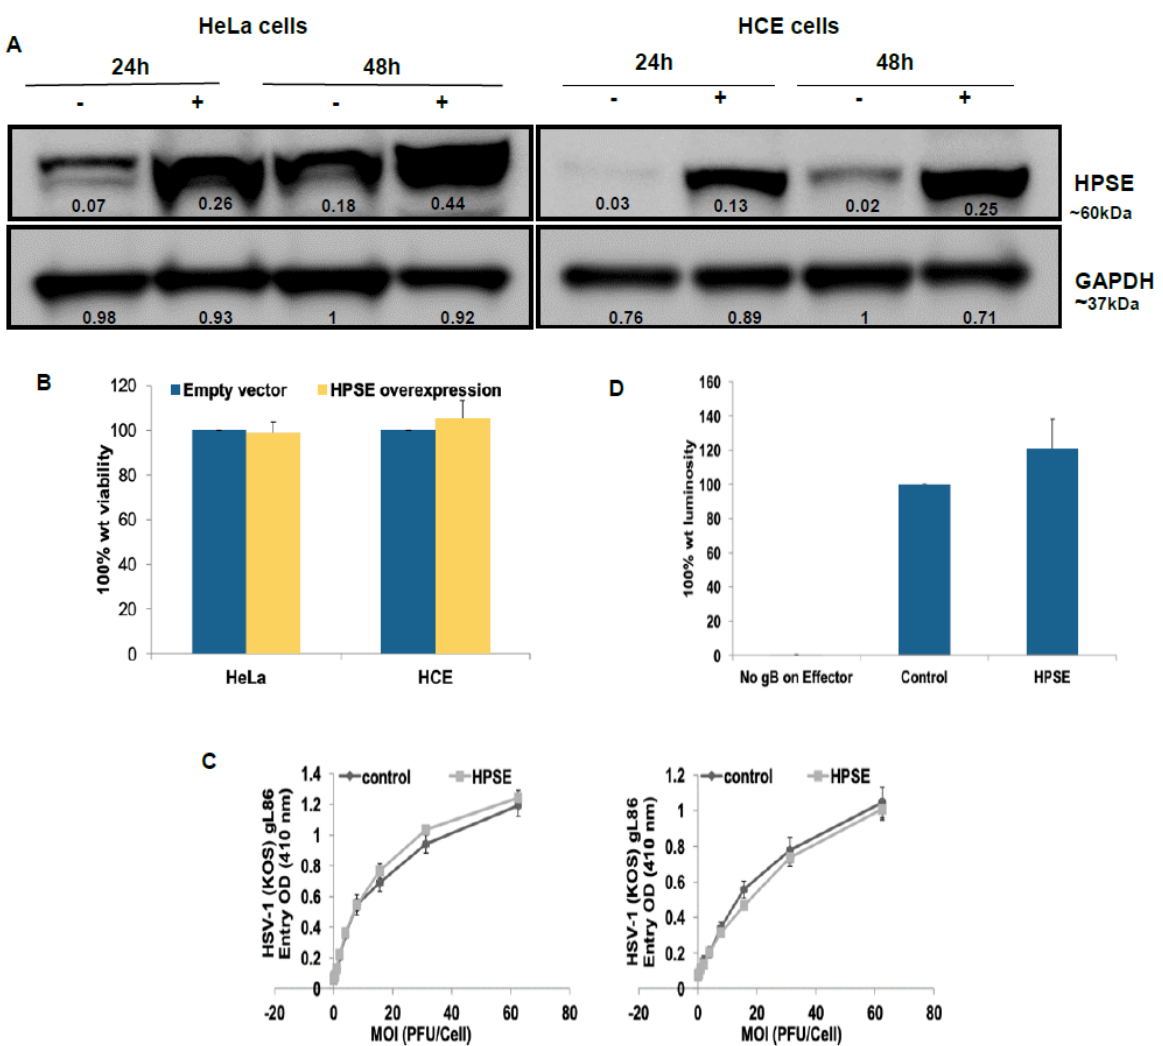
Figure 1. HPSE overexpression does not affect cell viability, cell entry, and cell–cell fusion in HeLa and HCE cells. ( A ) HeLa and HCE cells were transfected with human HPSE expression plasmid or with a control empty vector (control). Then, 24 and 48 h post transfection immunoblot of cell lysates were prepared and probed with anti-HPSE antibody. − : un-transfected cells, +: transfected cells. GAPDH protein level was measured as loading control. Representative blots of three independent experiments are shown. The densitometry quantification values are represented on the blot indicating the signal intensity with respect to the GAPDH (control). ( B ) Cells were grown in 96-well plates, transfected with HPSE expression plasmid or with a control empty vector. 24 h post transfection, triplicate wells were evaluated for cell viability using MTS assay. Results are expressed as 100% wild-type (wt) viability where they represent the percent corrected absorbance after subtracting the background absorbance, relative to empty vector transfected cells, and are mean ± 1 SD of three independent experiments. ( C ) HeLa and HCE cells were transfected with either HPSE expression plasmid (HPSE) or an empty vector (control). 24 h post transfection, cells were infected in a twofold serial dilution with the recombinant HSV-1 virus expressing β -galactosidase enzyme HSV-1(gL86). Cells were incubated with virus for 6 h at 37 ◦ C. Then, cells were washed, permeabilized, and incubated with ONPG substrate. Enzymatic activity was measured at 410 nm using an ELISA plate reader (Spectra Max 190, Molecular Devices, Sunnyvale, CA, USA). Results are presented as mean ± 1 SD of at least three independent experiments. ( D ) Target cells for CHO-K1 cells were either transfected with HPSE or with an empty vector (control) and mixed with effector cells 24 h post-transfection. As a negative control, target cells were mixed with effector cells that lack HSV-1 gB. Fusion was measured 16 h post mixing. Results are presented as mean ± 1 SD of five independent